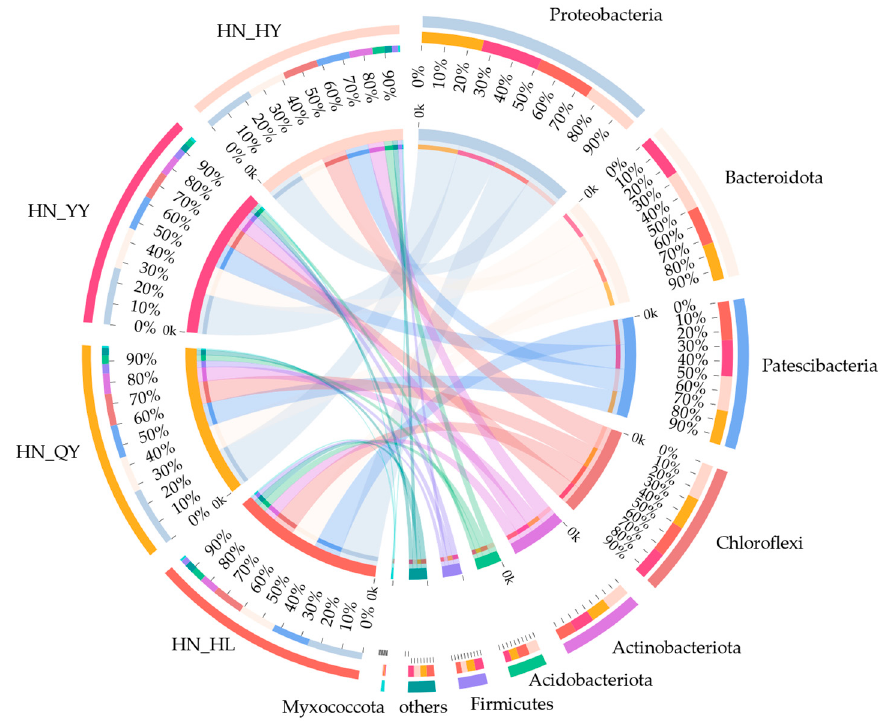
Figure 2. Four activated sludge samples and species relationship at the phylum level, including the anaerobic sludge (HN_YY), anoxic sludge (HN_QY), aerobic sludge (HN_HY), and return sludge (HN_HL).